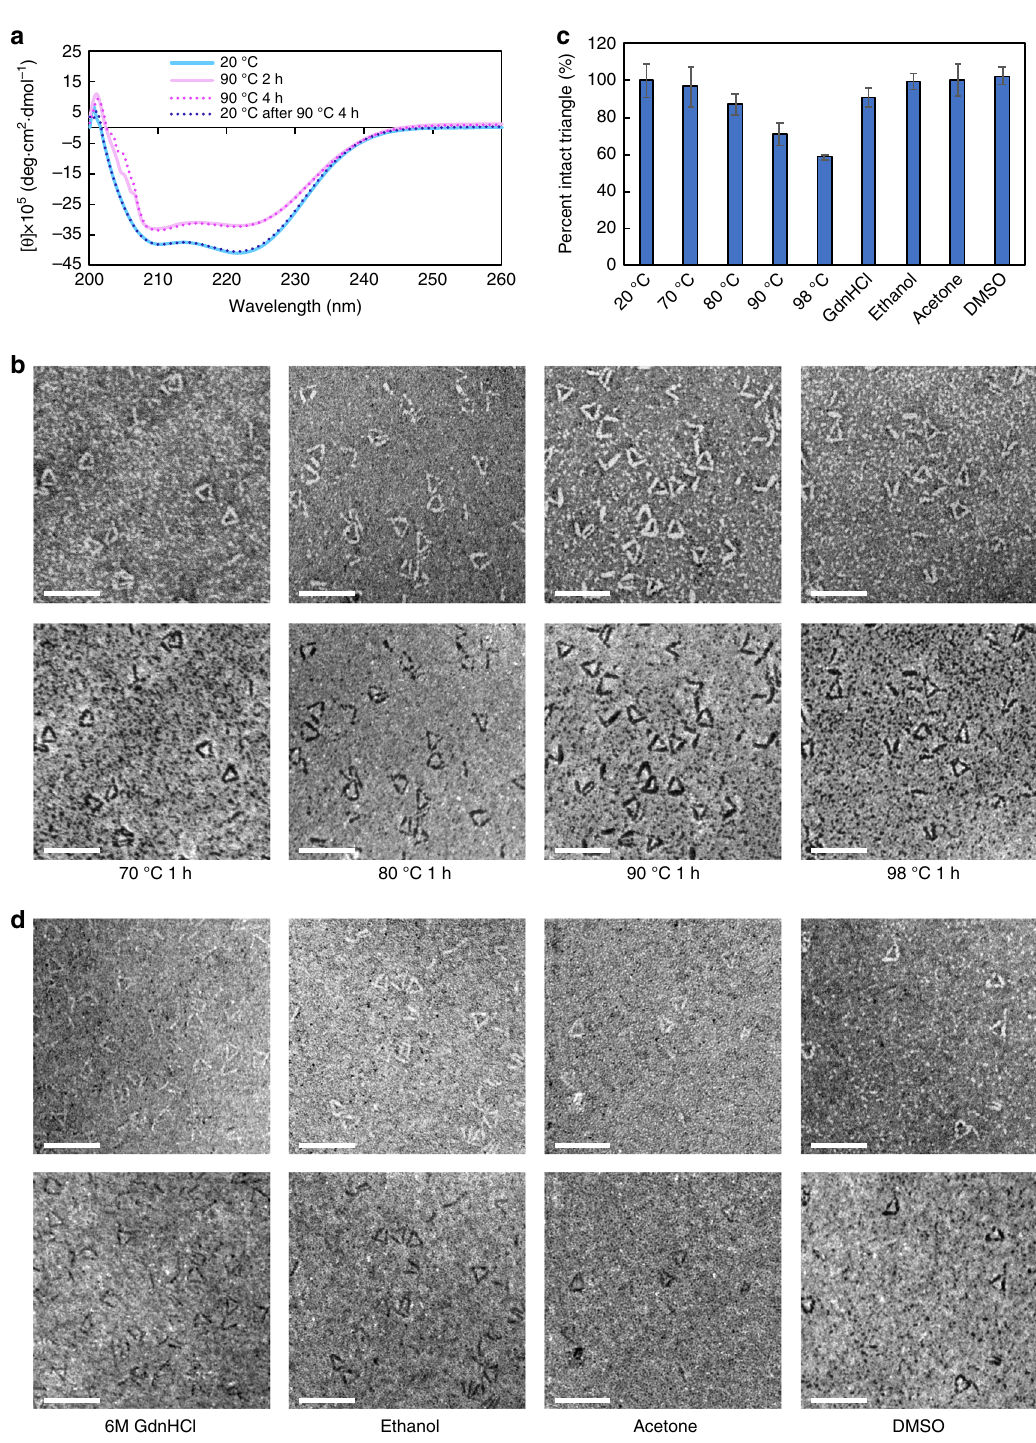
Fig. 4 Thermal and chemical stability of the protein triangles. a CD spectra of the Tri10t sample incubated at 20 and 90 °C. b Bright- fi eld (top) and dark- fi eld (bottom) STEM images of protein triangles after 1 h incubation at different temperatures. Scale bars, 50 nm. c Percentages of 3HB copies contained in intact triangular nanostructures after incubation in different conditions, normalized by pre-incubation values. Error bars represent the s.d. ( n = 3 denaturation experiment replicates). d Bright- fi eld (top) and dark- fi eld (bottom) STEM images of the protein triangles after incubation in chaotropic and organic solvents. Scale bars, 50 nm. Source data are provided as a Source Data fi